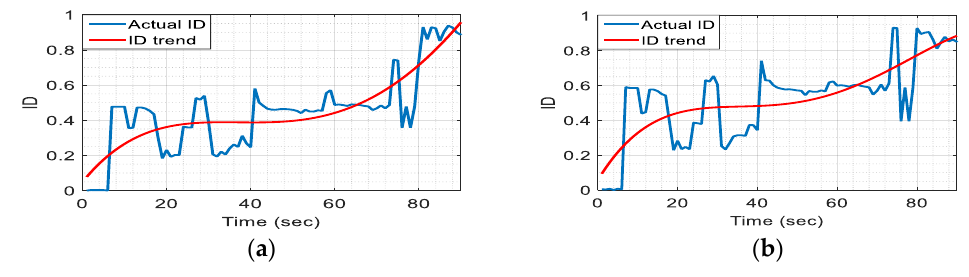
( b ) Figure 14. Video quality determined by FIS2: ( a ) Full image and ( b ) partitioned image. In order to demonstrate the manner the QoS and QoE values related to typical images with various levels of distortions, a number of images and their measurements are provided in Figure 15. The values were provided for the evaluations that were based on full and partitioned images. The range of both QoS and QoE from 0 (lowest quality) to 1 (highest quality). The partitioning of images